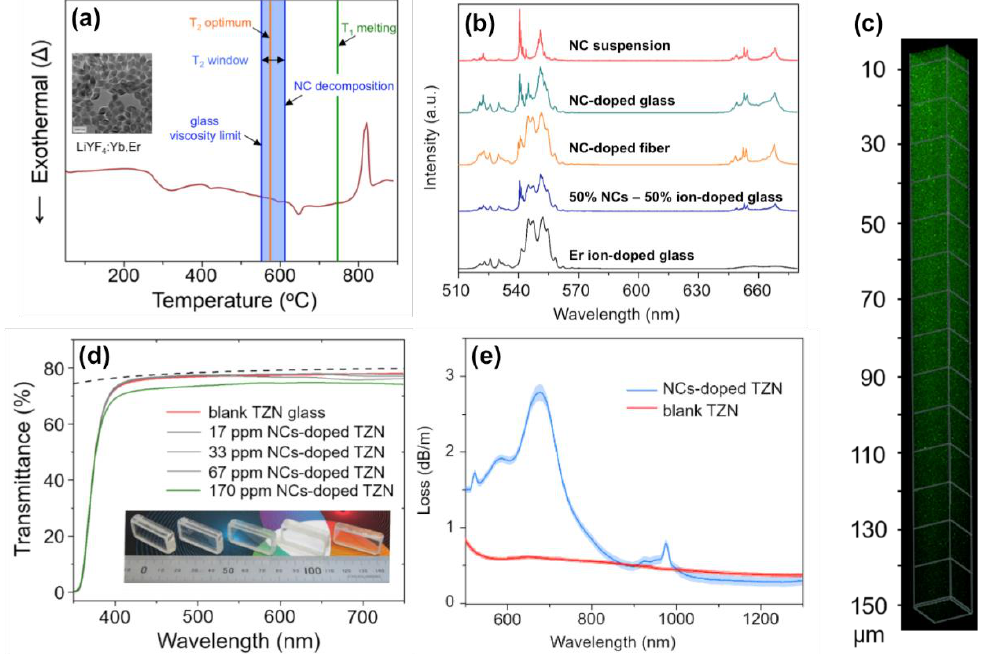
Figure 4. ( a ) Schematic showing SEM image and Differential Thermal Analysis (DTA) plot of upconversion nanocrystals (UPNCs), as well as batch temperature and doping temperature window; ( b ) Normalized upconversion spectra of NC suspension, NC-doped TZN glass and fiber, Er 3+ -doped TZN glass and simulated spectrum of 50% NCs and 50% Er 3+ ions in TZN glass; ( c ) 3D reconstruction of emitters in NC-doped TZN glass by stacking confocal microscopy images; ( d ) Transmittance spectra and photographs of NC-doped TZN glasses; ( e ) Optical attenuation spectra of NC-doped and undoped (blank) TZN glass fibers.